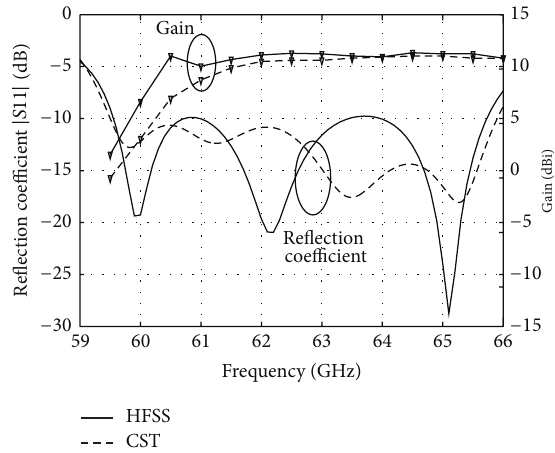
Figure 8: SIW 1 × 4 antenna array reflection coefficient and gain.